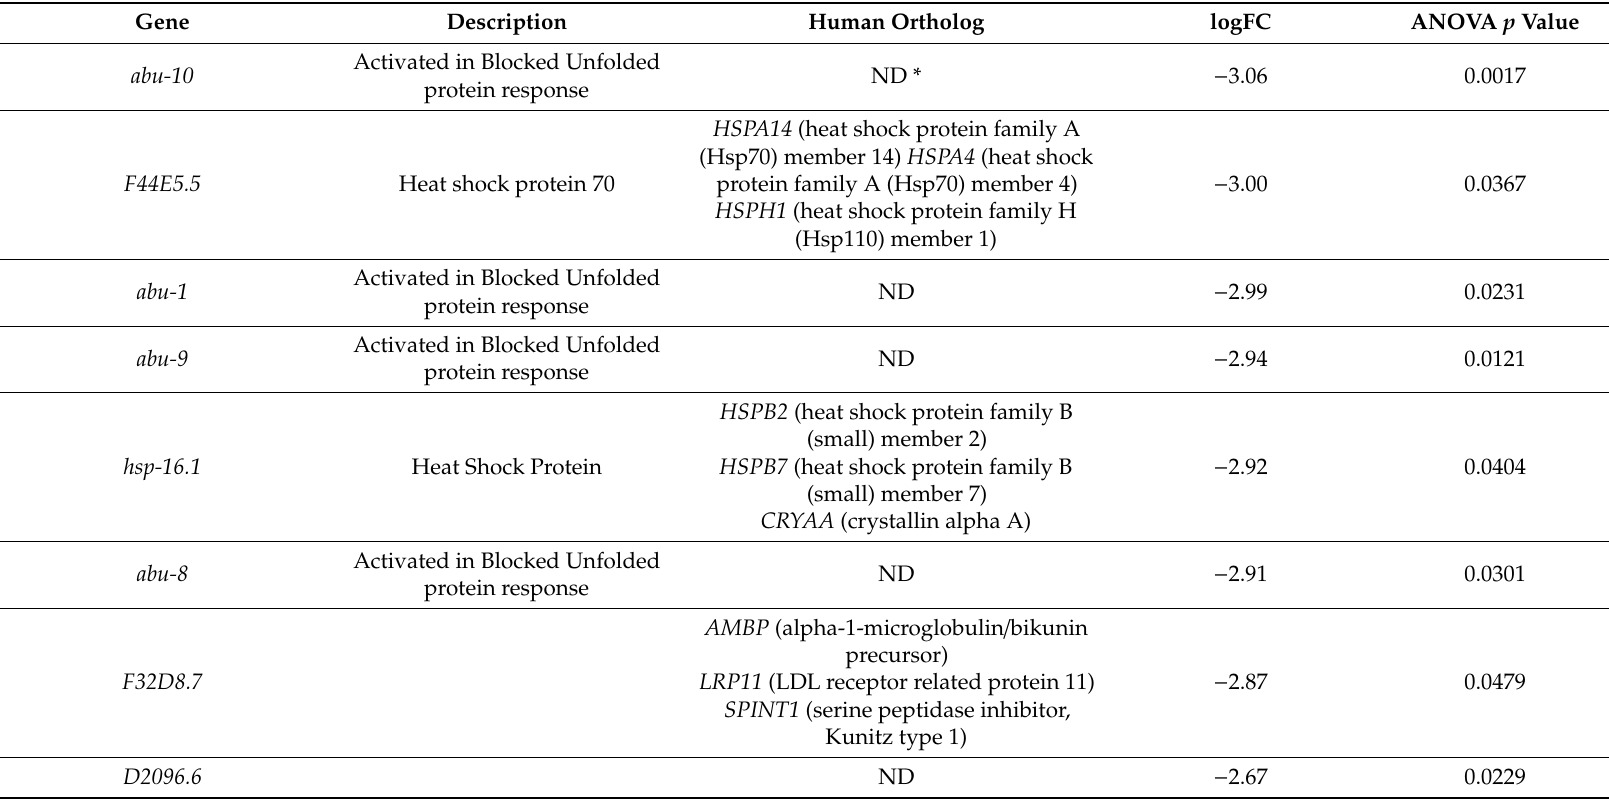
Table 4. Most a ff ected genes involved in UPR ER after treatment with